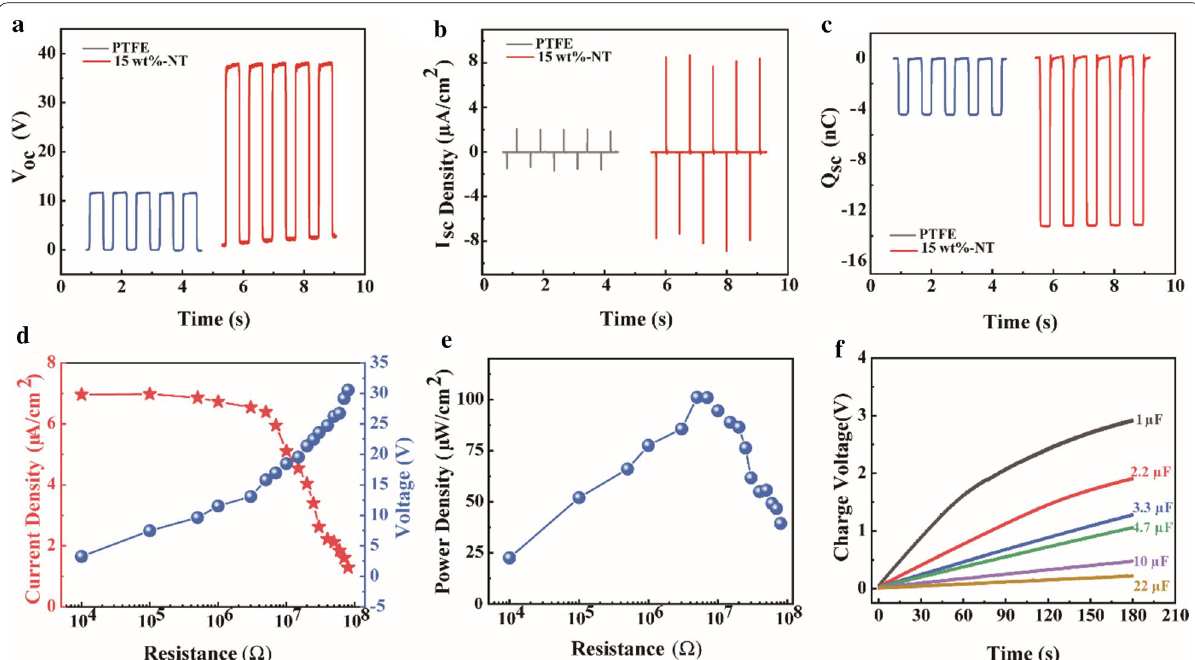
Fig. 4 The output performance of AM-TENG based on composite film with 15% Nb 2 CT x content or commercial PTFE film. a V oc , b I sc density, and c Q sc . d The output current density and voltage and e power density of am-TENG based on composite film with 15 wt% of Nb 2 CT x content as a function of external load resistance. f Analysis of charging performance of the alternate-layered MXene composite nanosheet films under different capacitance